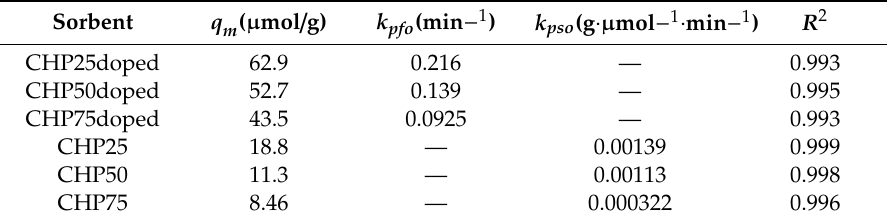
Table 5. Kinetic adsorption parameters of FL with the doped and undoped sorbents in their powdered